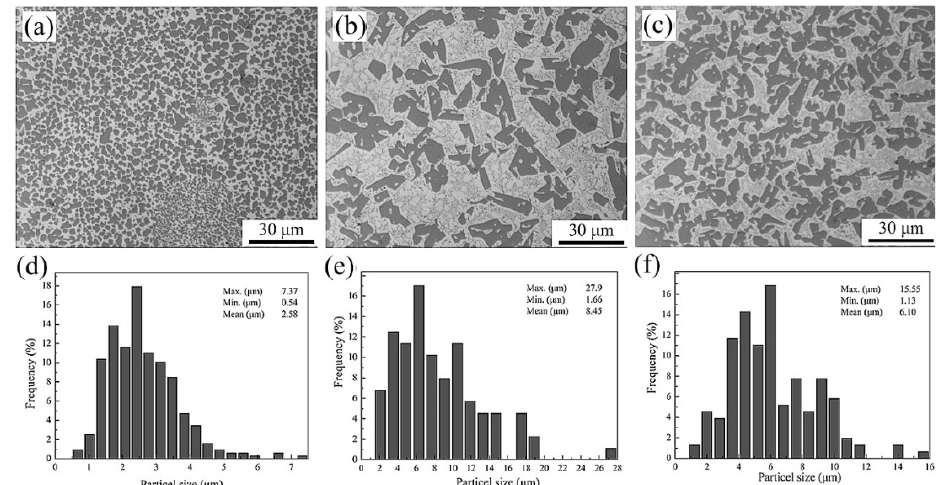
Figure 27. Optical microscopy images of the microstructure of SLM-processed parts obtained at a laser power of 320 W, ( a ) contour, ( b ) middle (contour offset) and ( c ) central regions and the corresponding dimension analysis of the primary silicon phase ( d ) contour, ( e ) middle and ( f ) central regions [152]. Copyright 2015. Adapted with permission from Elsevier Science Ltd. under the license